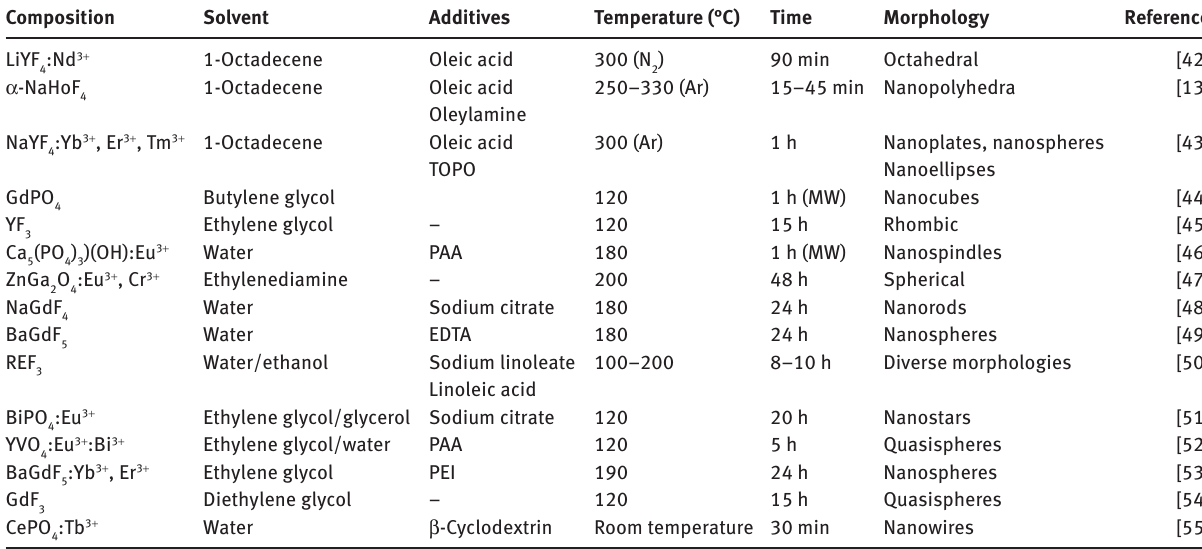
Table 1: Synthesis conditions for some RE-based